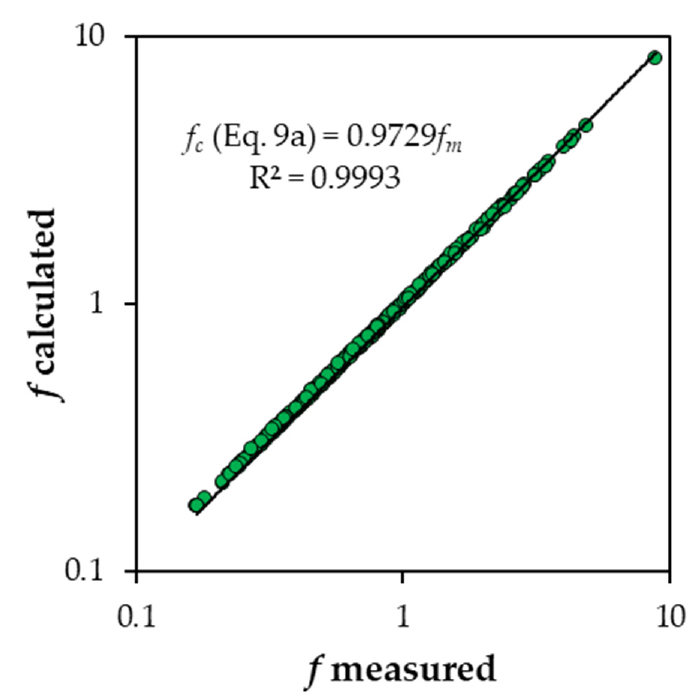
Figure 3. Comparison between the f values and those calculated applying Equation (9a), obtained for the “Random” arrangement by Canovaro et al. [38], to the dataset by Ferro and Giordano [31]. The friction factor values calculated applying Equation (9a) to this dataset are characterized by errors in estimate E , which are distributed according to the normal law (Figure 4), less than or equal to ± 5% for 98.8% of cases and less than or equal to ± 2.5% for 82.4% of cases.